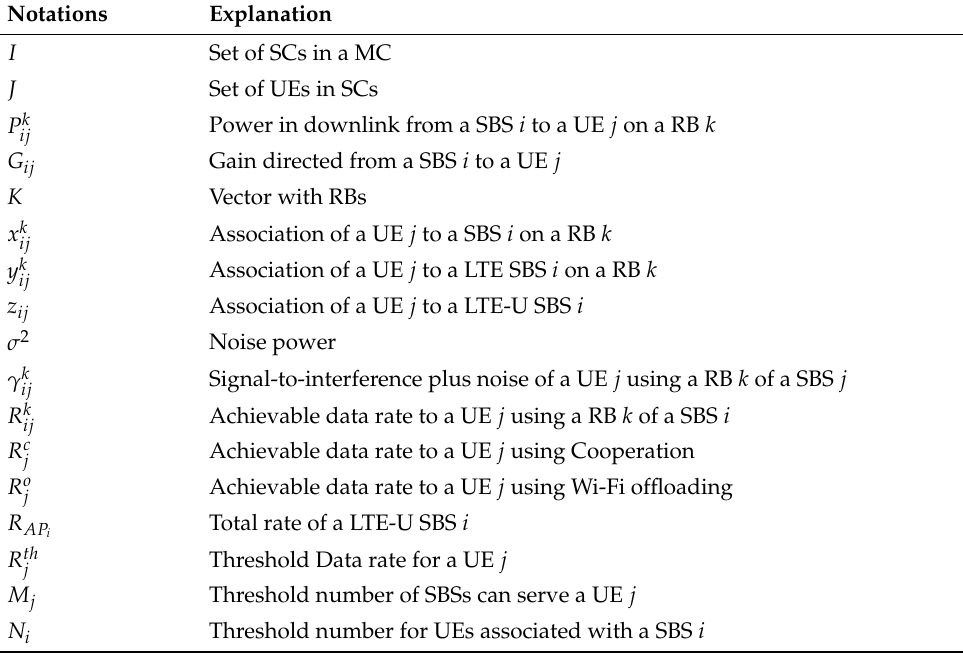
Figure 1. Transmission scenarios for data rate enhancement in SC network. Table 1. Explanation of